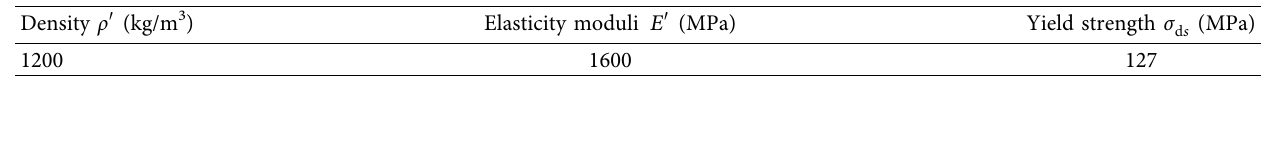
Table 3: Mechanical parameters of polyurethane resin.